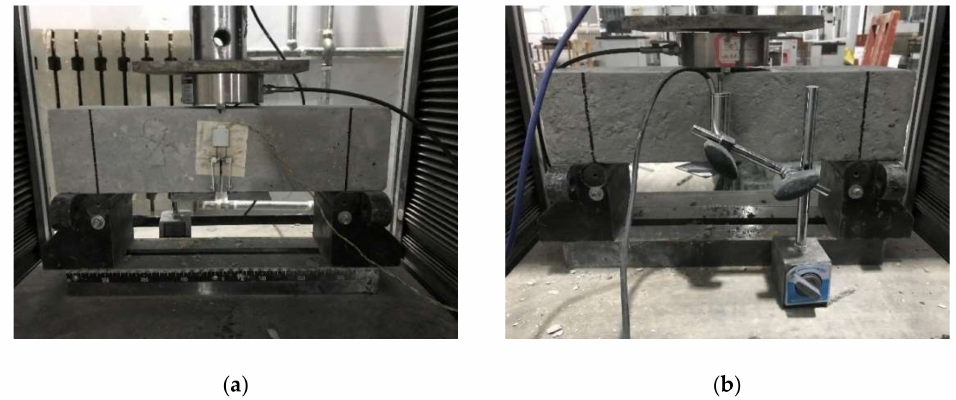
Figure 5. Field diagram of fracture test: ( a ) clip extensometer layout and ( b ) electric displacement meter. In the load-CMOD curve, the CMOD corresponding to peak load ( F max ) is the critical CMOD ( V c ). Analogously, the corresponding fracture toughness under the peak load ( F max ) is called unstable fracture toughness ( K S ), which can be calculated by Equation (3). IC = K S IC